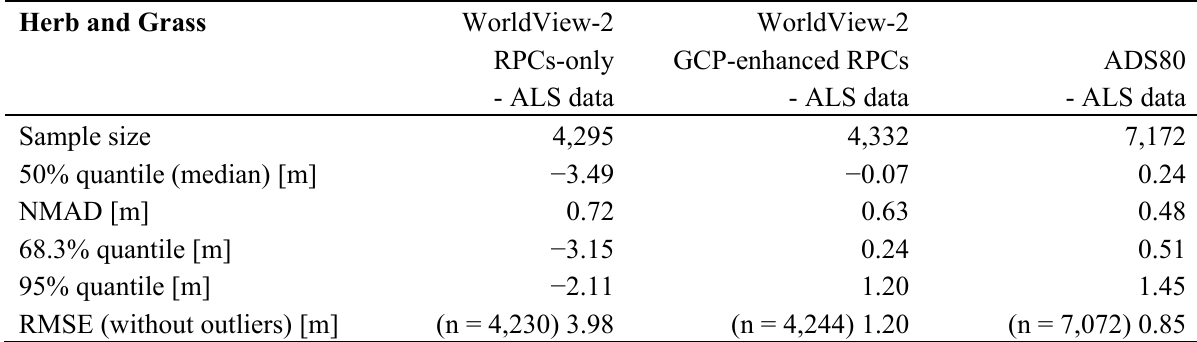
Table 7. Herb and grass vegetation. Vertical accuracy measures of the three digital surface models in comparison with the airborne laser data.